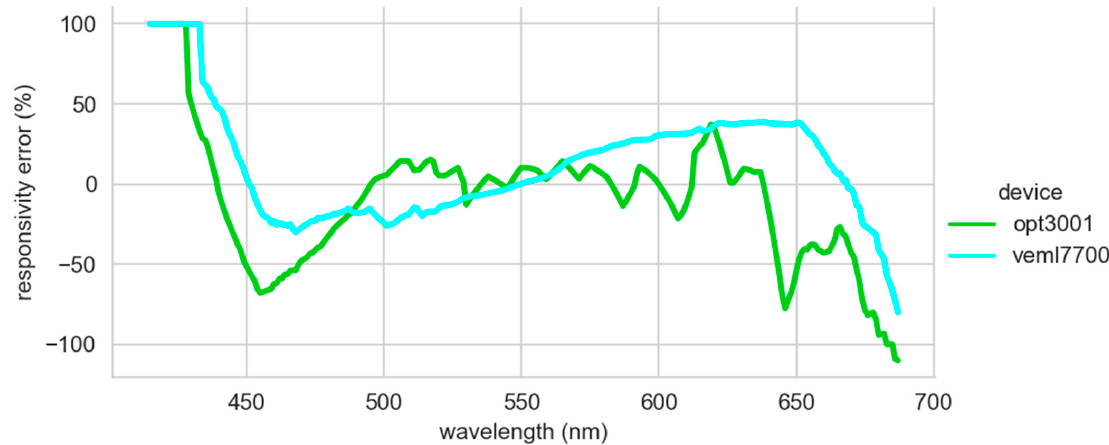
Figure 3. The relative error in the responsivity between low-cost sensors and the human eye.